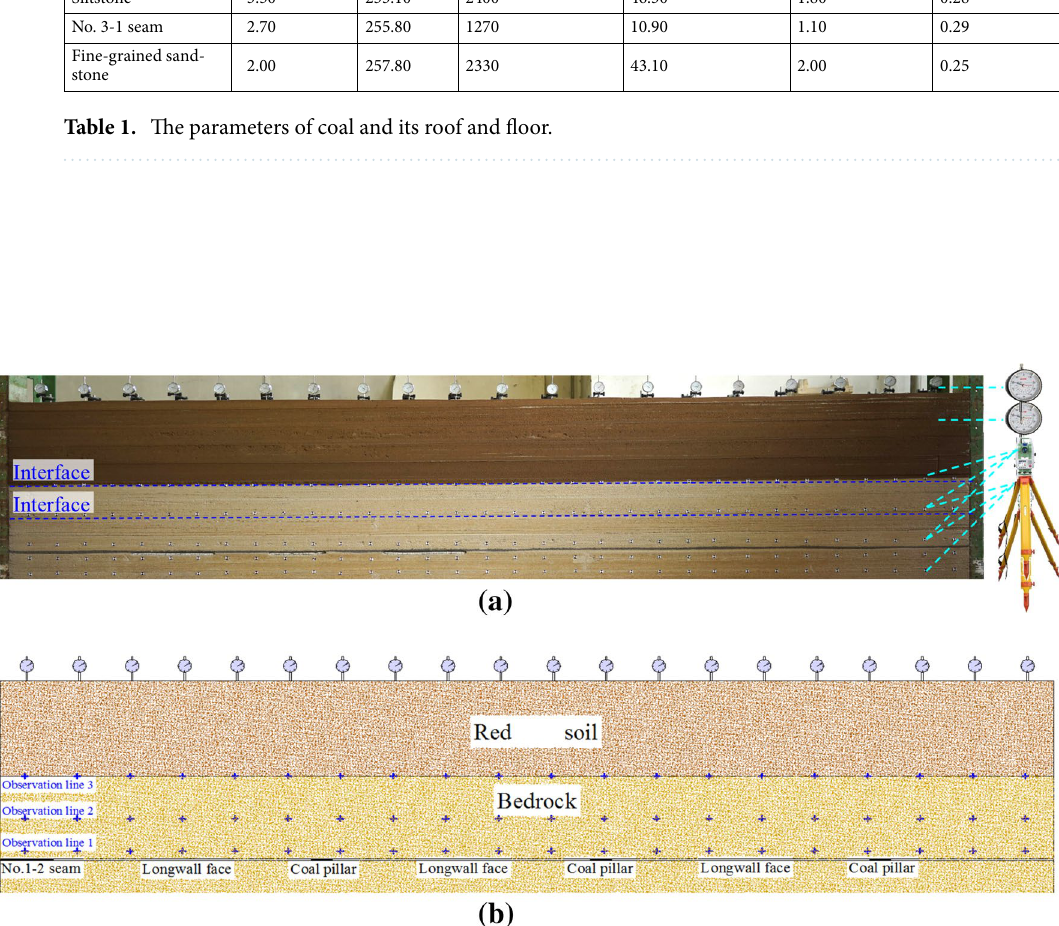
Figure 2. Physical simulation model: ( a ) Simulation model; ( b ) Position of observation